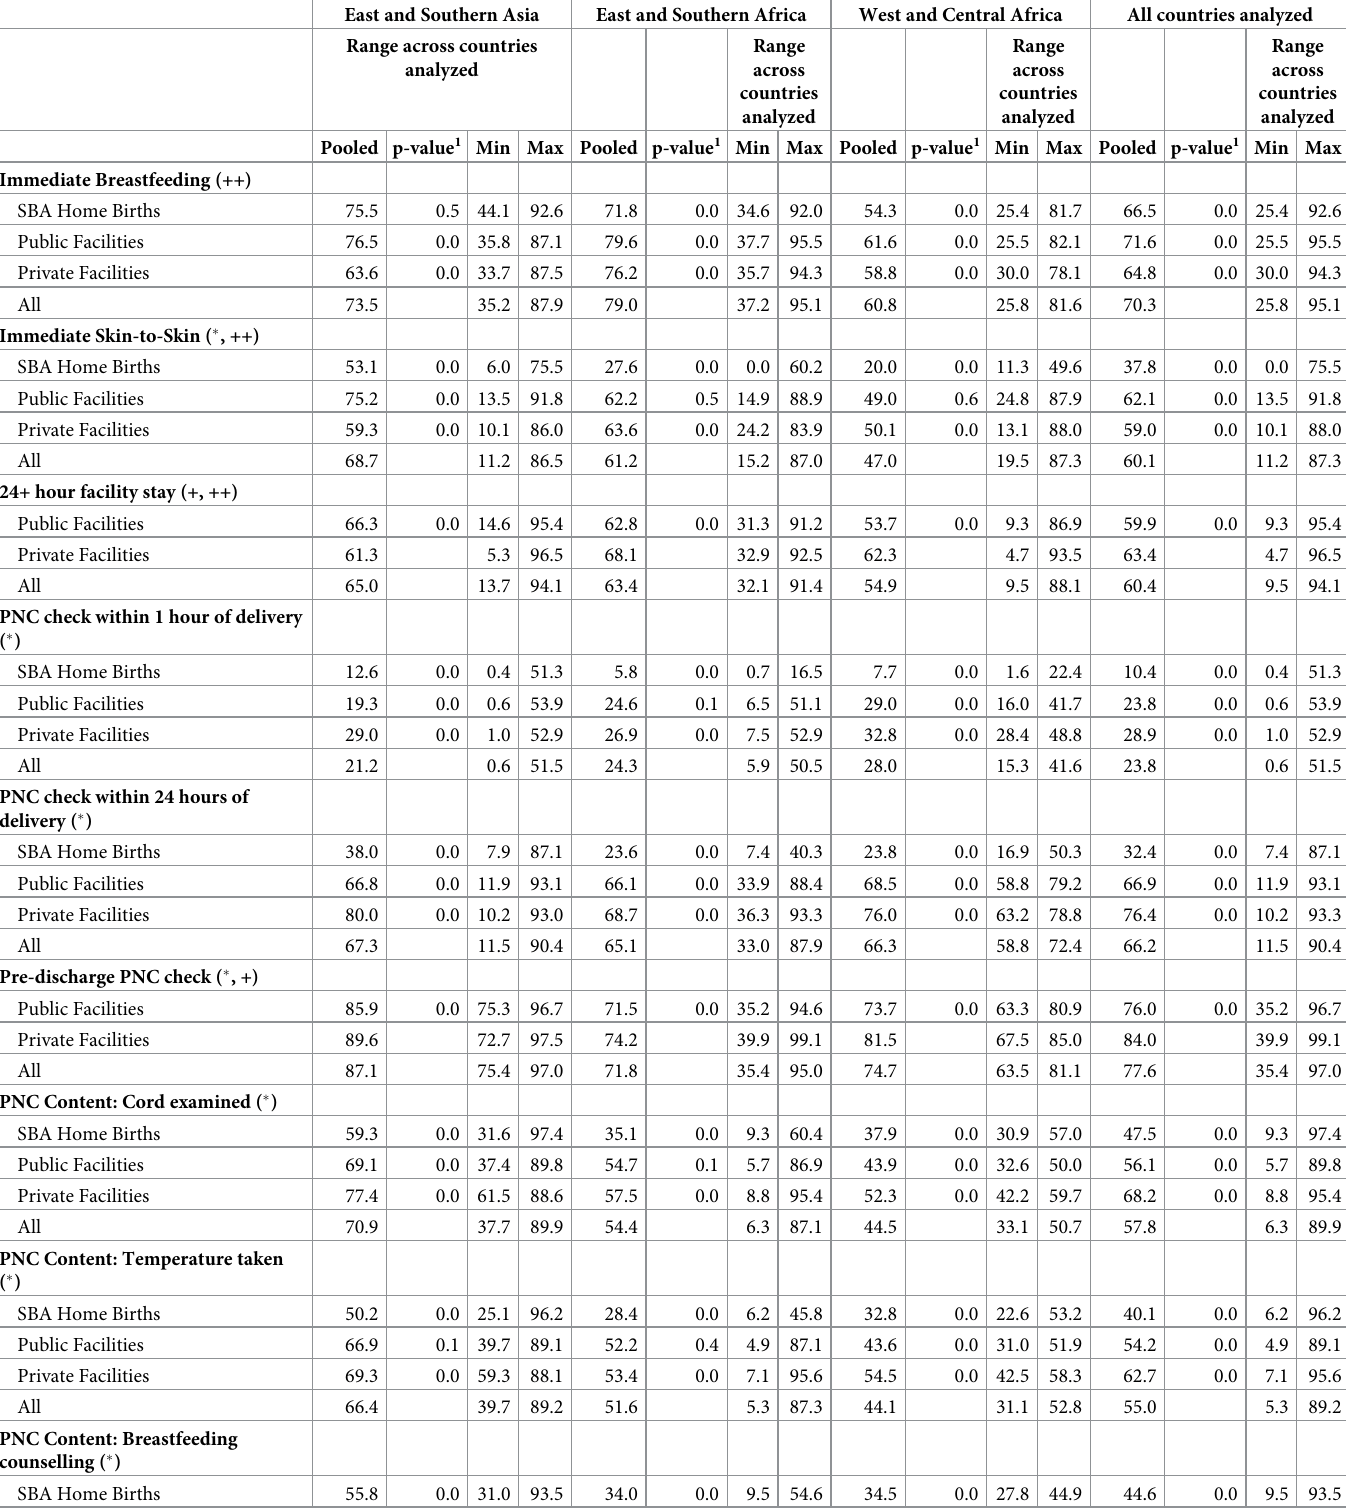
Table 3. ENC and PNC received by neonates born in the 2 years prior to survey by region and delivery source, DHS data from 45 countries.